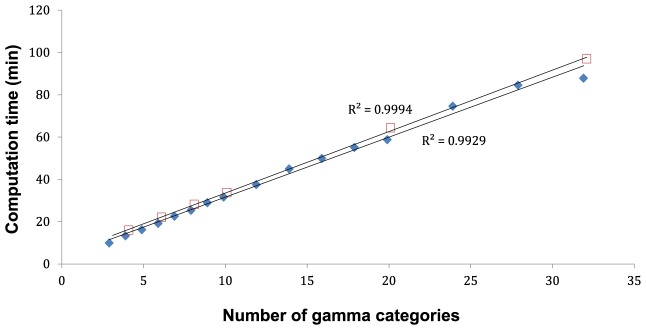
Computation time (min) as a function of the number of gamma rate categories, for the hominin mitogenome data set (ii).Filled blue and empty red markers represent computation time using TrN+Γ and TrN+I+Γ models, respectively. Each Markov chain was run for 106 steps on a six-core processor (Intel Xeon W3690).